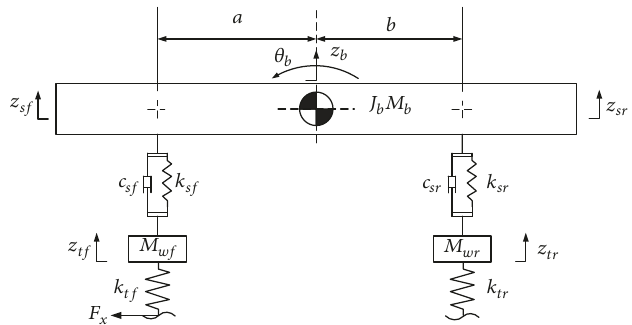
Figure 5: Suspension vertical and vehicle body pitch vibration model.